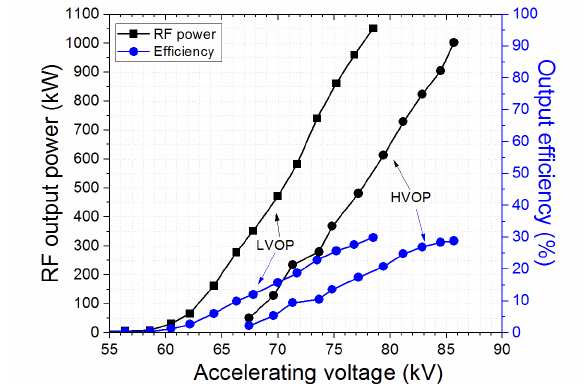
Fig. 2. RF power and corresponding efficiency (in non- depressed collector operation) with respect to the accelerating voltage for the LVOP (V acc  78 kV, I b  45 A) and the HVOP (V acc  86 kV, I b  40 A).